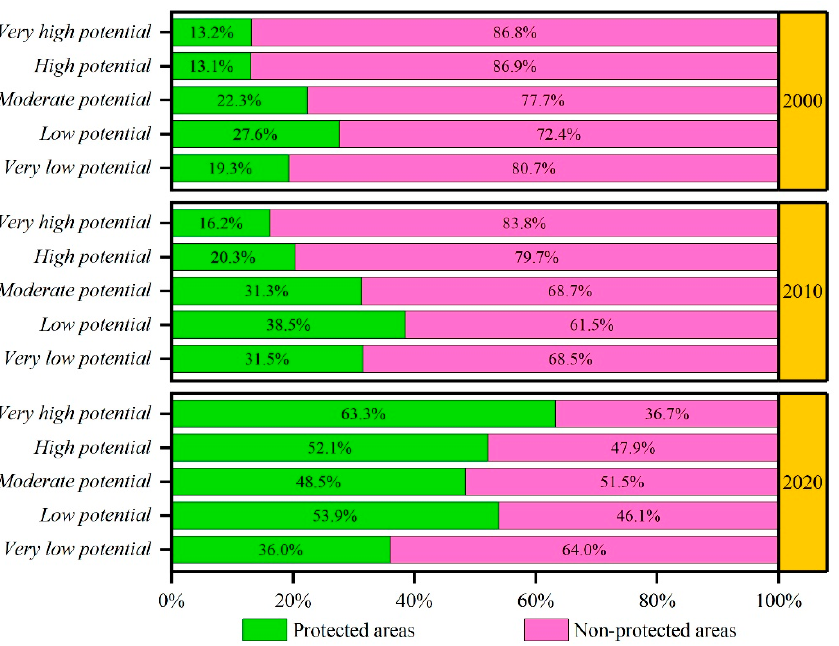
Figure 6. The proportion of INRPI in protected areas and non-protected areas from 2000 to 2020.